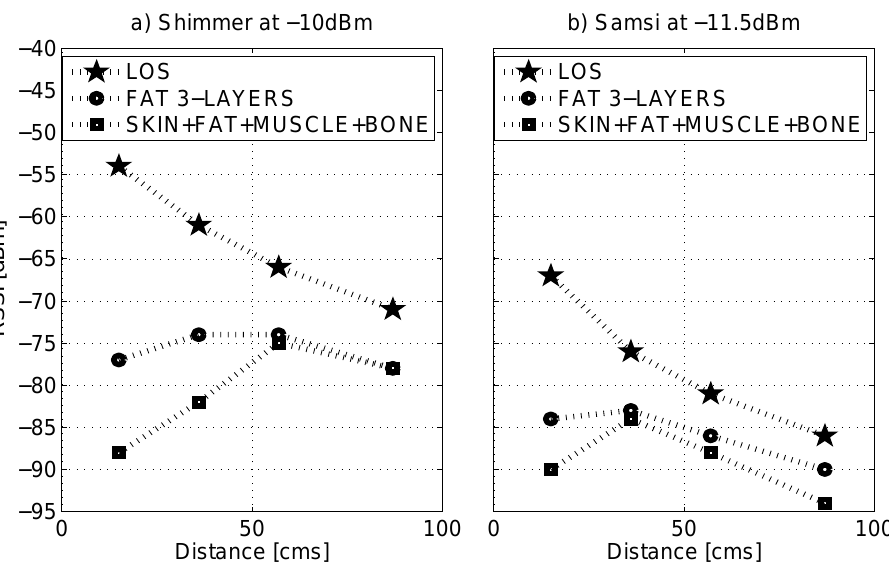
Figure 4. RSSI vs . Distance for LOS/NLOS links in outdoor